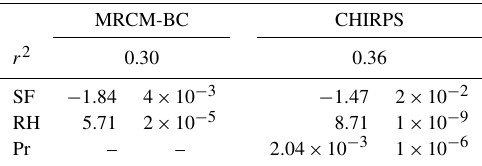
Table 3. Runoff coefficient model results. The bottom three lines show coefficient values (left-hand column) and their statistical sig- nificance ( p value, right-hand